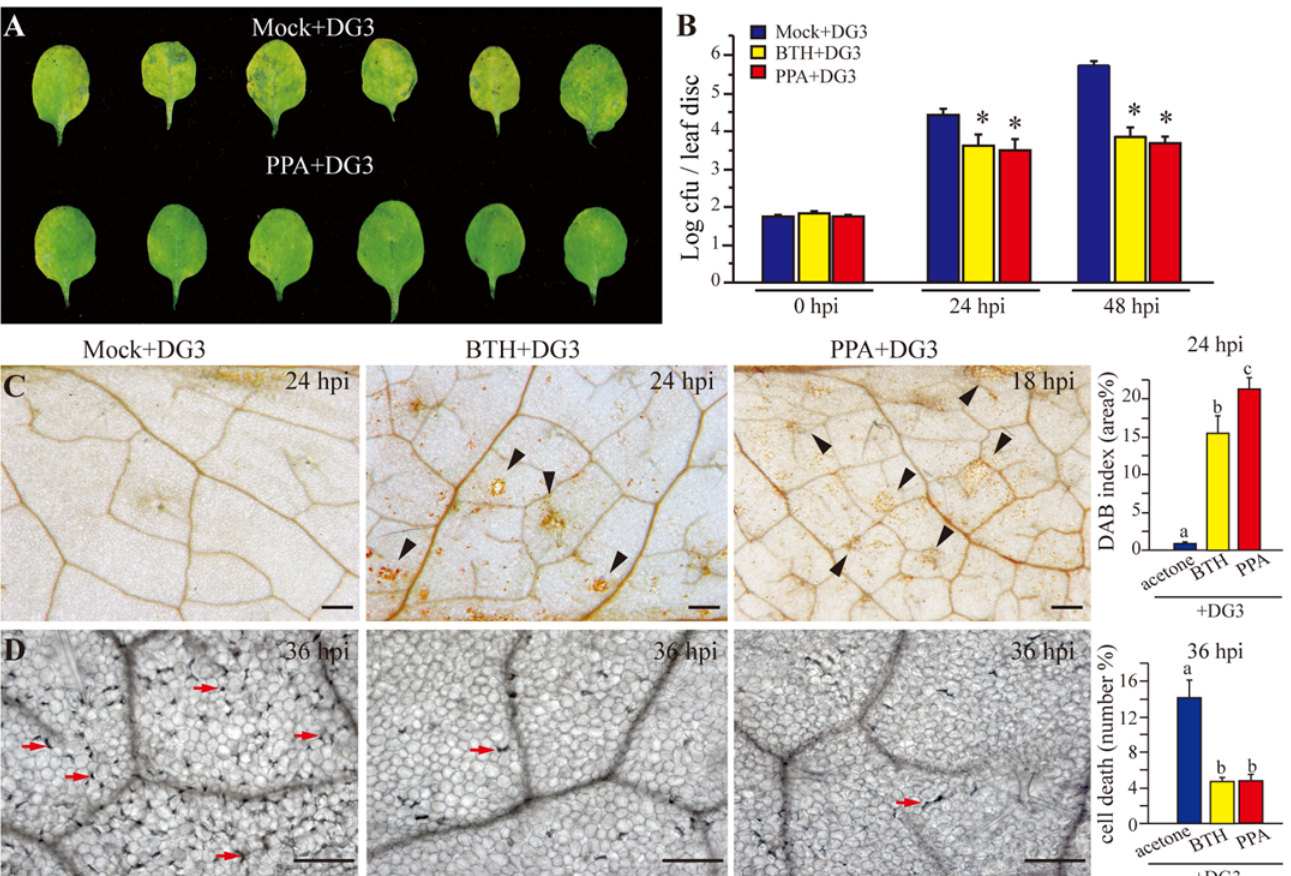
Fig 3. PPA triggered resistance responses after bacterial infection. A , Disease symptoms of 19-day-old leaves pretreated with 40 μ M PPA for 2 days, followed by infiltration of 10 mM MgSO 4 (Mock) or Pseudomonas syringae pv. maculicola strain DG3 (DG3) (OD 600 = 0.001) 72 h post inoculation. B , Leaf discs were harvested at 0 dpi, 1 dpi and 2 dpi and monitored for bacterial growth. Asterisks indicate P < 0.05 using Fisher's PLSD. This experiment was repeated at least six times with similar results. C and D , Microscopy images of DAB staining ( C ) and trypan blue staining ( D ). Twenty-two-day-old leaves pretreated with 0.3% acetone (mock), 100 μ M BTH for 3 days and 40 μ M PPA for 2 days, then infiltrated with P . syringae DG3 (OD 600 = 0.005) for the indicated times. Note yellow DAB deposits (black arrowheads) and dead cells (red arrows). Bar = 200 μ m. The right panel in ( C ) shows quantification of DAB deposit area measured by ImageJ. The right panel in ( D ) shows numbers of dead cells calculated by manual count in the field of view. Error bars represent the means ± SE from six replicates in each experiment, and data sets marked with different letters indicate significant differences (P < 0.05, PLSD-test). This experiment was repeated at least three times.